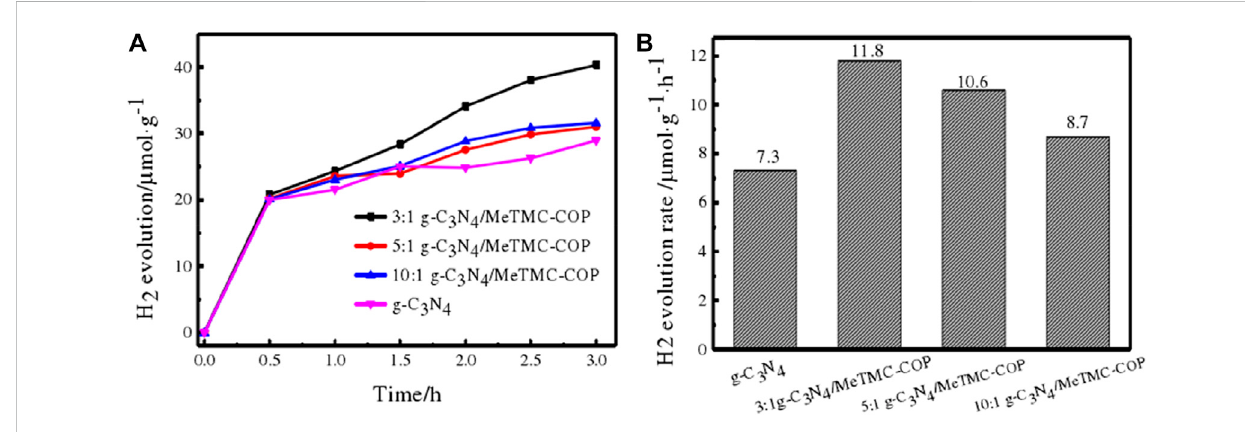
FIGURE 12 Time curves for photocatalytic hydrogen generation using g-C 3 N 4 are shown in (A) , along with rate constants (B) for various g-C 3 N 4 /Me TMC-COP ratios.